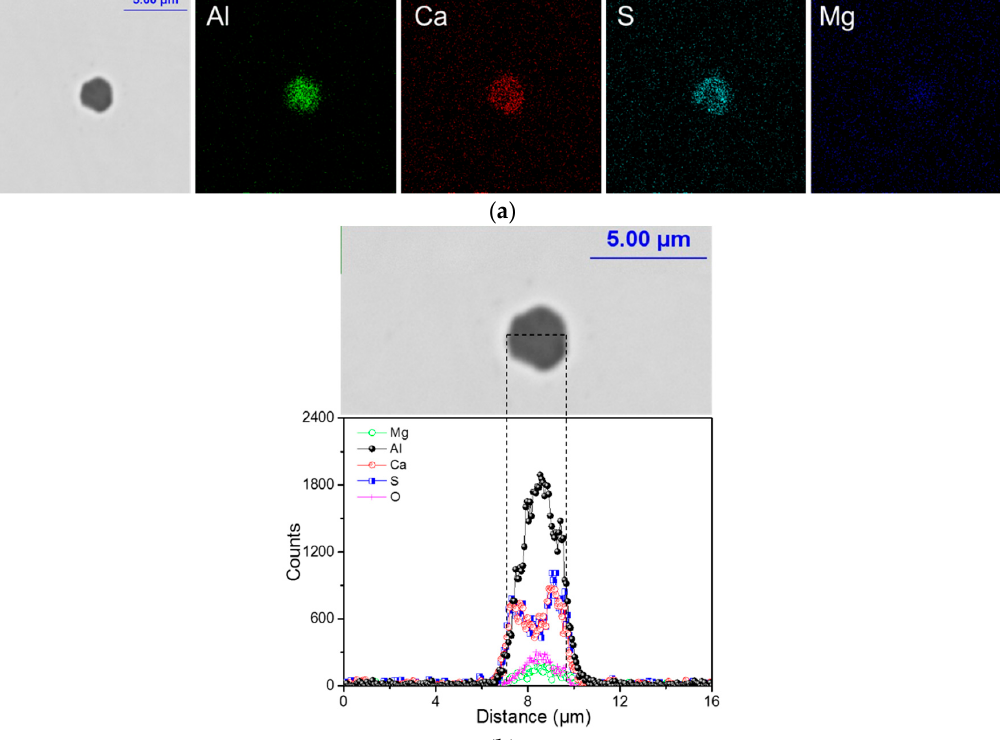
Figure 4. Typical inclusion in the steel before heat treatment: ( a ) Mapping, ( b ) line scanning.